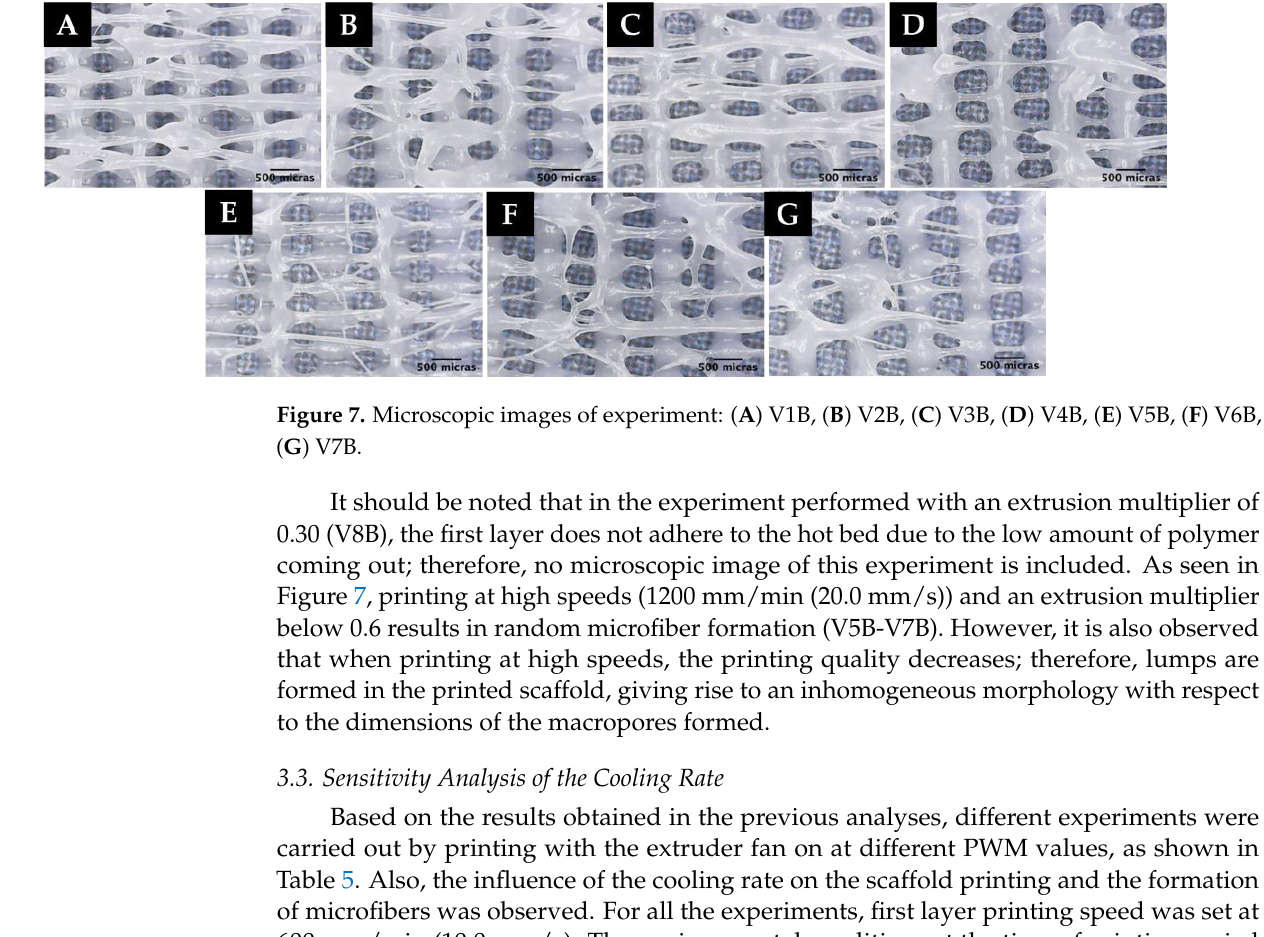
Table 5. Printing parameters of experiments T1B-T13B.